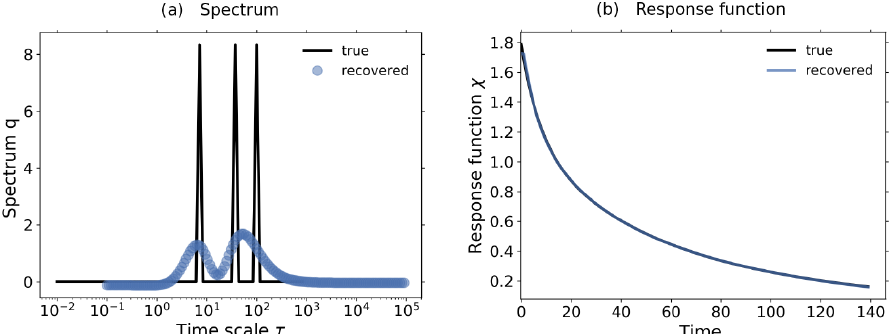
Figure E5. Spectrum q λ and response function χ(t) recovered from a 1% experiment performed with the toy model described in Part 1 taking an underlying discrete spectrum with three timescales τ = 7, τ = 37, and τ = 100. The data were taken with SNR ∼ O ( 10 4 ) − O ( 10 5 )